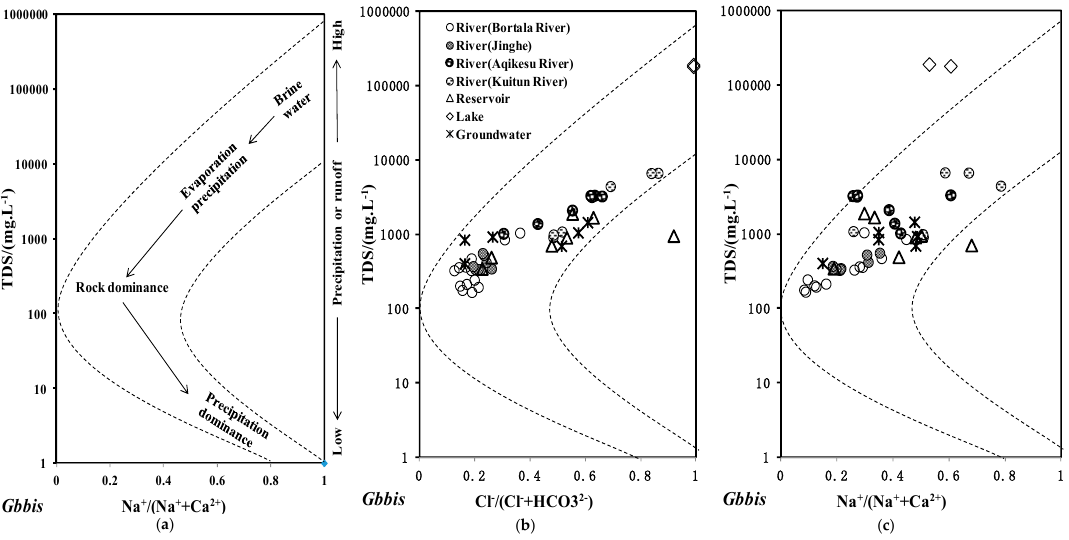
Figure 6. Gibbs plot: ( a ) comparison of natural processes that define the water chemistry of water on the Gibbs (1970) diagram; ( b ) TDS versus Cl − /(Cl − + HCO 3 − ); ( c ) TDS versus Na + /(Na + + Ca 2+ ). The molar ratios of (Na + + K + )/SO 42 − were almost 1:8 (Figure 7a). The molar ratios of (Na + + K ) / Cl were almost 1:1 and 2:1 for most of the groundwater, reservoir, and river samples (Figure 7c), + / − suggesting the simultaneous dissolution of halite. The molar ratios of Ca 2 SO 42 were mostly between − 1:3 and 1:8 (Figure 7b), implying that additional SO 42 came both from gypsum dissolution and mirabilite dissolution or anthropogenic contamination. Most groundwater, reservoir, and river samples + / + / − − lay above the 1:1 line, indicating dolomite dissolution, as seen in Figure 7d. The Ca 2 Cl and Mg 2 Cl ratios were mostly from 1:1 to 5:1 and 1:4 to 2:1 in groundwater (Figure 7e,f), showing that halite + + or sea salt dissolution is more significant than carbonate dissolution. Lake water had more (Na + + / + / − − − K ) / Cl with lower molar ratios of Ca 2 Cl and Mg 2 Cl (approximately 1:3) relative to groundwater + / + (Figure 7c,e,f), implying the dominance of evaporite dissolution. The Ca 2 Mg 2 ratios were 1:1 and 1:2 for water samples from the lake, most reservoirs, a few rivers, and groundwater near Ebinur Lake, whereas it was between the 4:1 and 1:5 lines in most groundwater and surface water samples from the upstream part of the river (Figure 7d). Therefore, the higher ion concentrations of water near the Ebinur Lake Protected Area compared to most groundwater and surface water in the upstream part of river can be ascribed to mineral dissolution and precipitation input, as well as surface evaporation. As a result, the recharge source of groundwater was similar to that of rivers, and both could be influenced by evaporation and carbonate